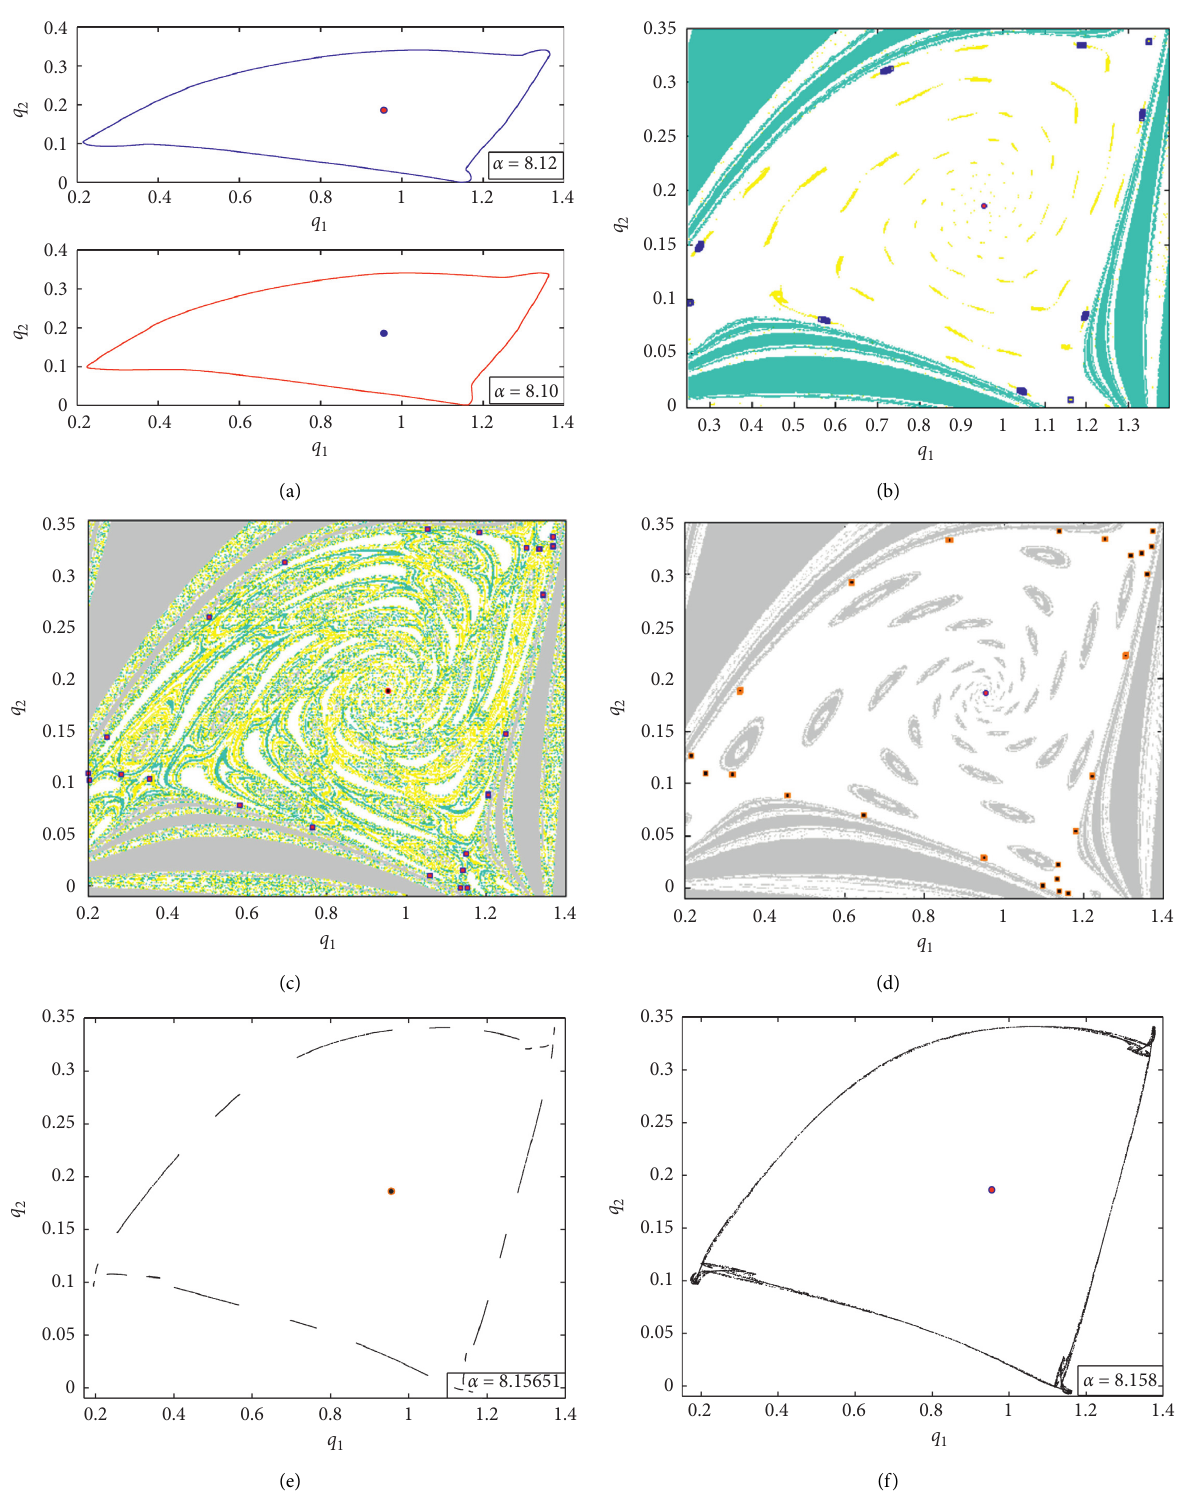
Figure 3: The fixed parameter values are c α � 8 . 10 and α � 8 . 12. (b) Basin of attraction of multiple stable period 10-cycle at α � 8 . 143. (c) Stable period 23-cycle and its basin of attraction at α � 8 . 149. (d) Stable period 23-cycle and its basin of attraction at α � 8 . 1565. (e) Phase plane of chaotic attractor at α � 8 . 15651. (f) Phase plane of chaotic attractor at α � 8 .